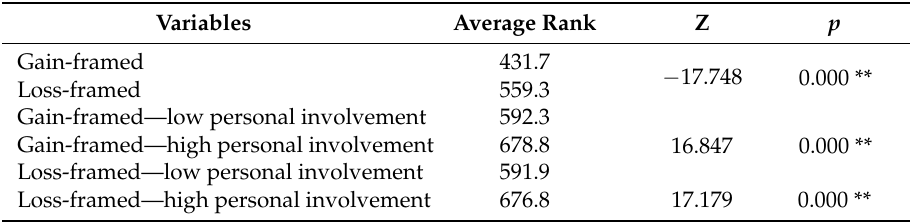
Table 4. Wilcoxon signed rank sum test for testing framed